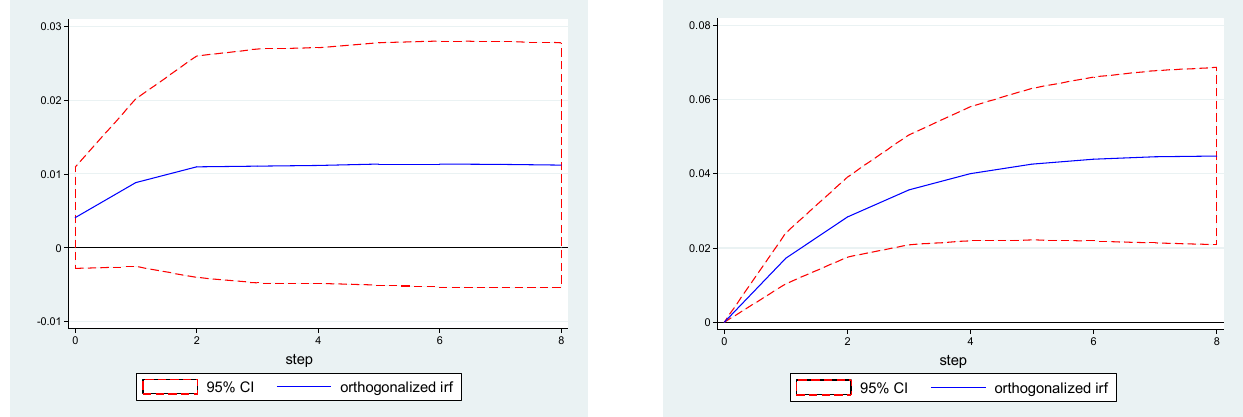
Figure 3. Impulse Response Function of lnCurrency to Expect and Shortcapital. In sum, our results show that the RMB appreciation expectation could lead to short- term capital inflow through increasing RMB